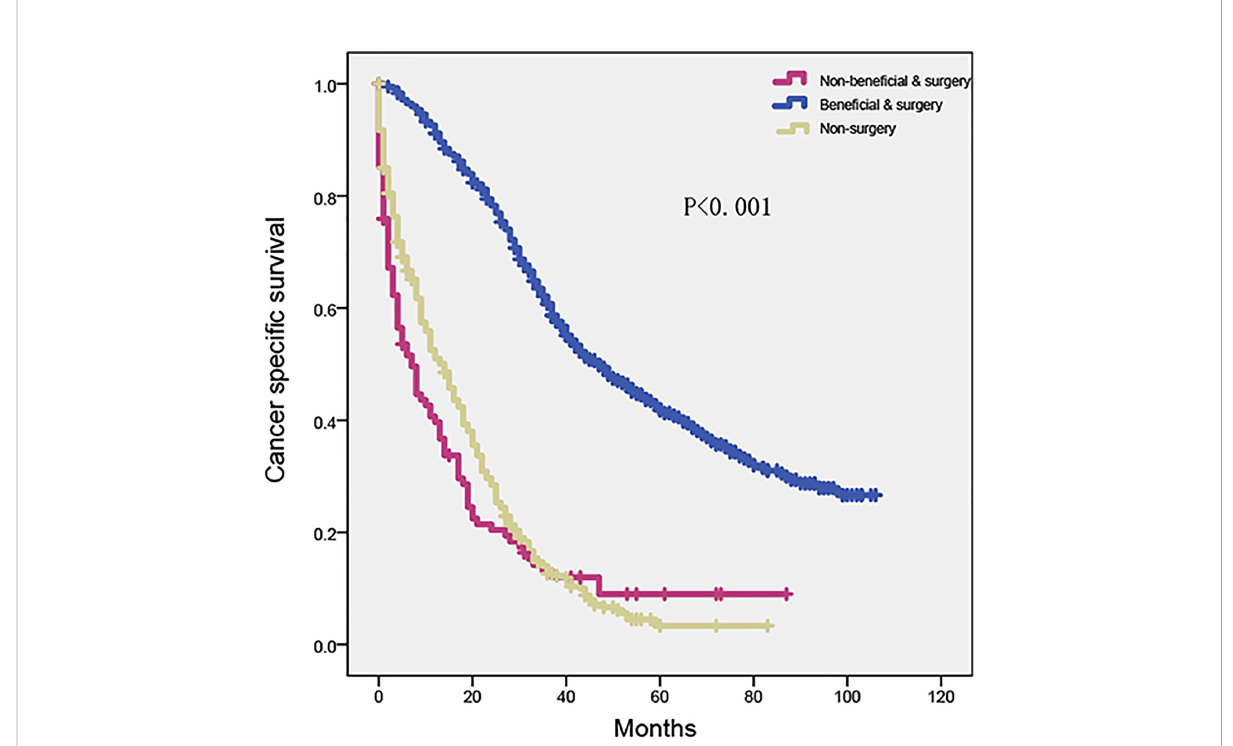
FIGURE 6 Kaplan – Meier plot to differentiate bene fi cial group according to CRLM nomogram in SEER cohort. SEER, Surveillance, Epidemiology, and End Results; CRLM, colorectal cancer with liver